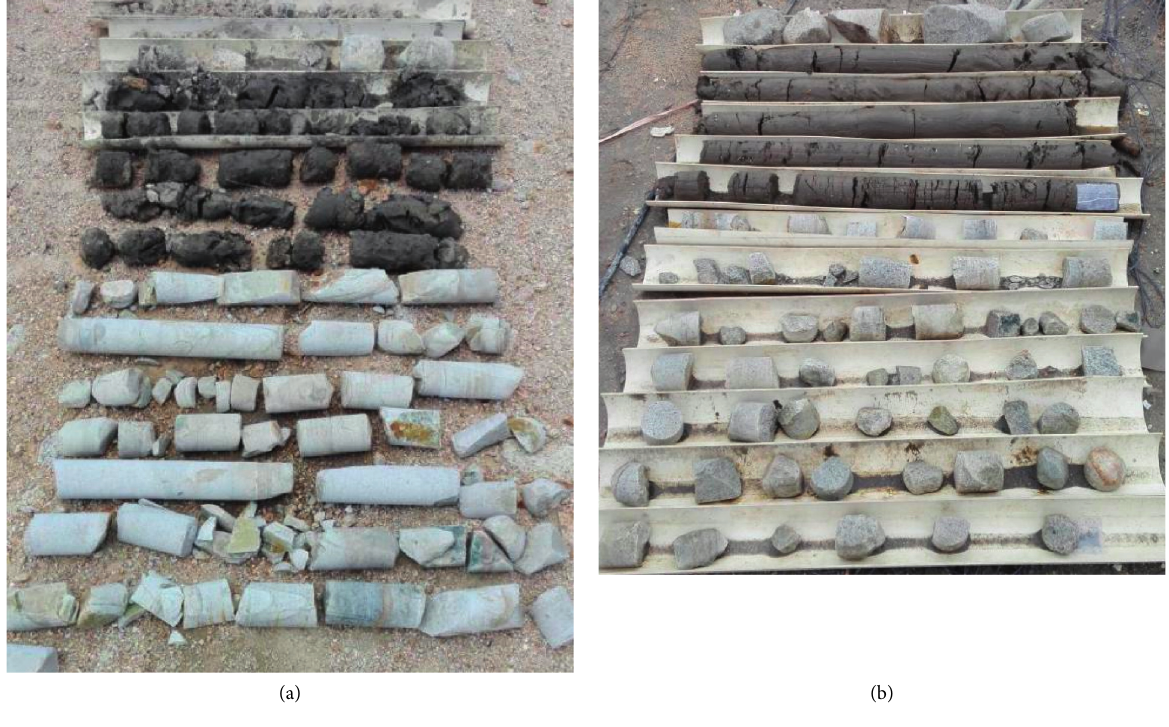
Figure 3: Rock cores (a) before blasting and (b) after blasting. Table 1: Physical and mechanical parameters of artificial fill.